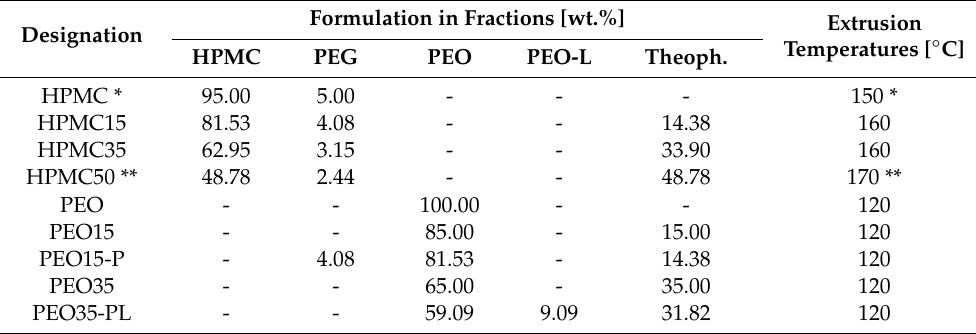
Table 1. Filament formulations and extrusion die